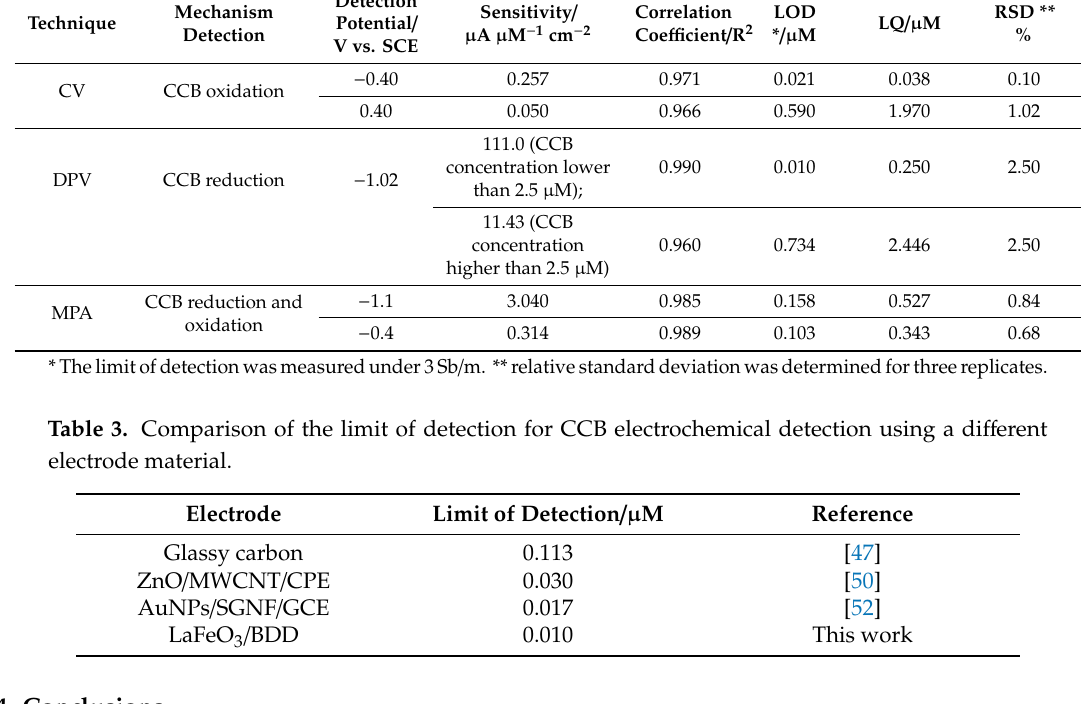
Table 2. The electroanalytical parameters for CCB determination using LaFeO 3 / BDD electrode. Technique